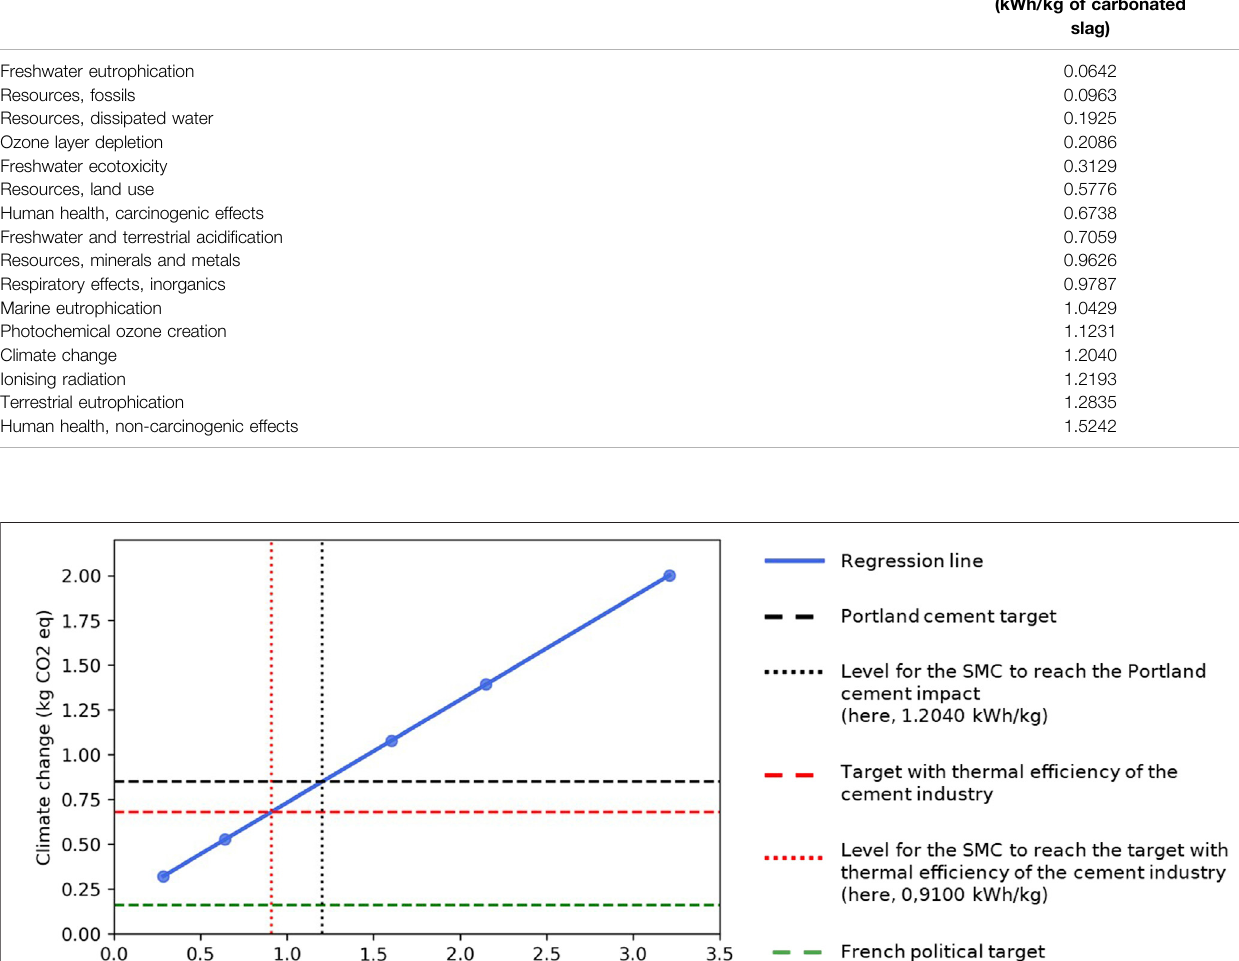
Frontiers in Built Environment |